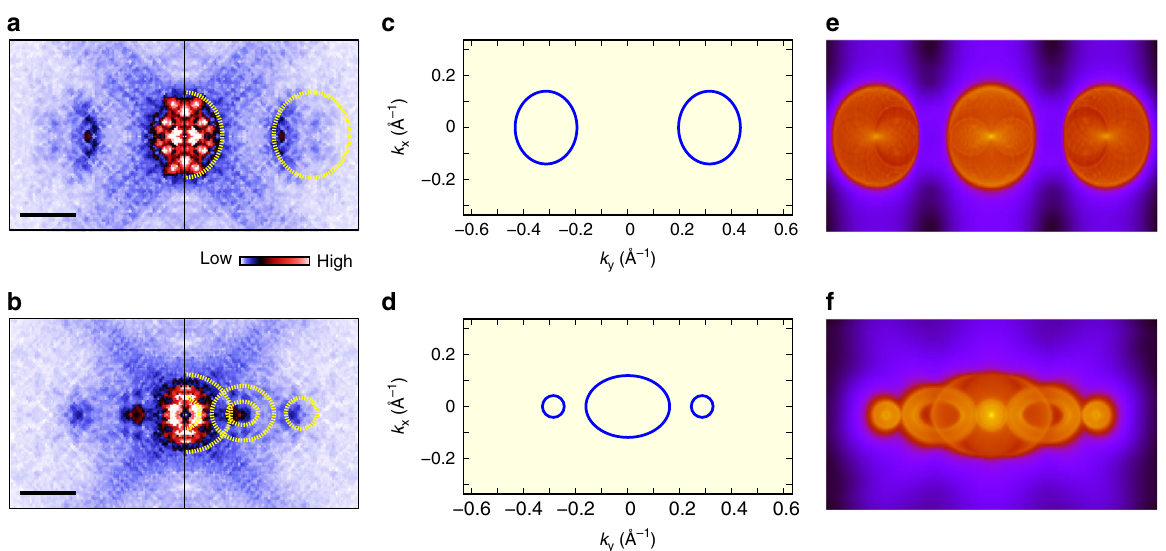
Fig. 3 Comparison of the QPI patterns with the DFT simulation. a , b The fast Fourier transform (FFT) images transformed from the d I /d V maps taken at + 70 and − 80 mV, respectively. The length of the scale bar is 0.3 Å − 1 . The FFT images are symmetrized and drift-corrected. Only the patterns in the fi rst Brillion Zone are shown. The overlaid yellow dashed ovals brie fl y outline the QPI patterns. c , d Schematic constant energy contours at E = + 100 mV and E = − 70 mV, respectively. e , f The DFT-simulated QPI patterns based on c and